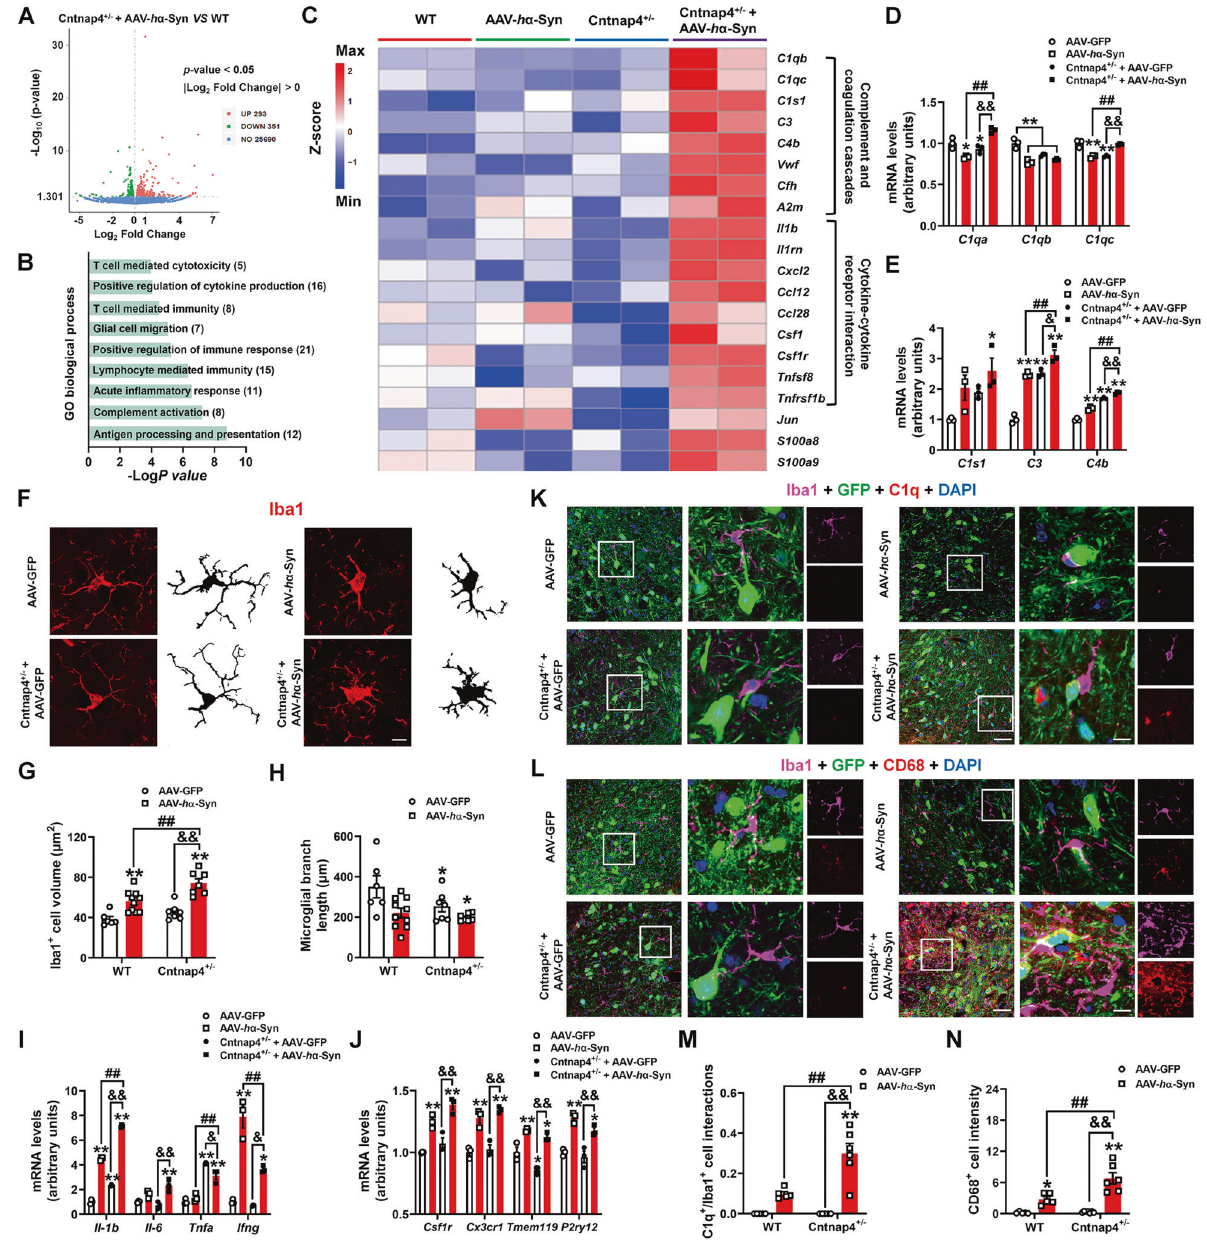
and WT mice. C Representative DEGs among WT, AAV- h α -Syn, Cntnap4 + / − , and Cntnap4 + / − + AAV- h α -Syn mice are shown in a heatmap. Note that the genes C1qb , C1qc , C1s1 , C3 , C4b , Vwf , Cfh , and A2m were enriched in the “ complement and coagulation cascades ” pathway, Il1b , Il1rn , Cxcl2 , Ccl12 , Ccl28 , Csf1 , Csf1r , Tnfsf8 , and Tnfrsf1b were enriched in “ Cytokine-cytokine receptor interaction ” pathway. D , E The mRNA expression levels of C1qa , C1qb , C1qc , C1s1 , C3 , and C4b were determined by qRT-PCR. n = 3 per group. F Immuno fl uorescence staining of Iba1- positive cells in the SNpc of WT and Cntnap4 + / − mice injected with either AAV-GFP or AAV- h α -Syn. Scale bars: 30 μ m. Skeletal images are shown in the right column. G , H Quanti fi cation of the volume and branch length of Iba1-positive cells in ( F ); n = 6 – 10. I , J The mRNA expression levels of Il-1b , Il-6 , Tnfa , Ifng , Csf1r , Cx3cr1 , Tmem119 , and P2ry12 were determined by qRT-PCR; n = 3 per group. K , L Co-staining of Iba1 with C1q ( K ) and CD68 ( L ) in the SNpc of WT and Cntnap4 + / − mice injected with either AAV-GFP or AAV- h α -Syn. Scale bars: 40 μ m. Magni fi ed images are shown in the right column. Scale bars: 8 μ m. M , N Quanti fi cation of the interaction area of Iba1 with C1q ( K ) and CD68 positive cell intensity ( L ); n = 5 – 7. Results are expressed as the mean ± SEM. ** p < 0.01, * p < 0.05 vs . WT; ## p < 0.01 vs. AAV- h α -Syn; && p < 0.01, & p < 0.05 vs. Cntnap4 + / − . Statistical signi fi cance was determined using two-way ANOVA + Bonferroni ’ s multiple comparisons